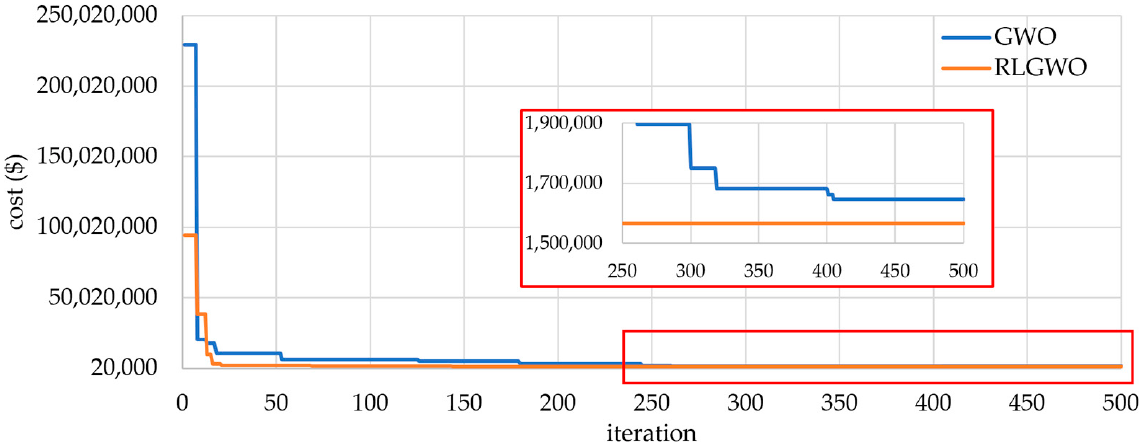
41 Figure 9. Results for different methods for the 110 ‐ unit system (50 trials): ( a ) boxplot of the final generation cost; ( b ) time and number of hits of the minimum solution. 5.1.4. Test System 4 This case study considers 140 generators belonging to Korea’s power system. Twelve